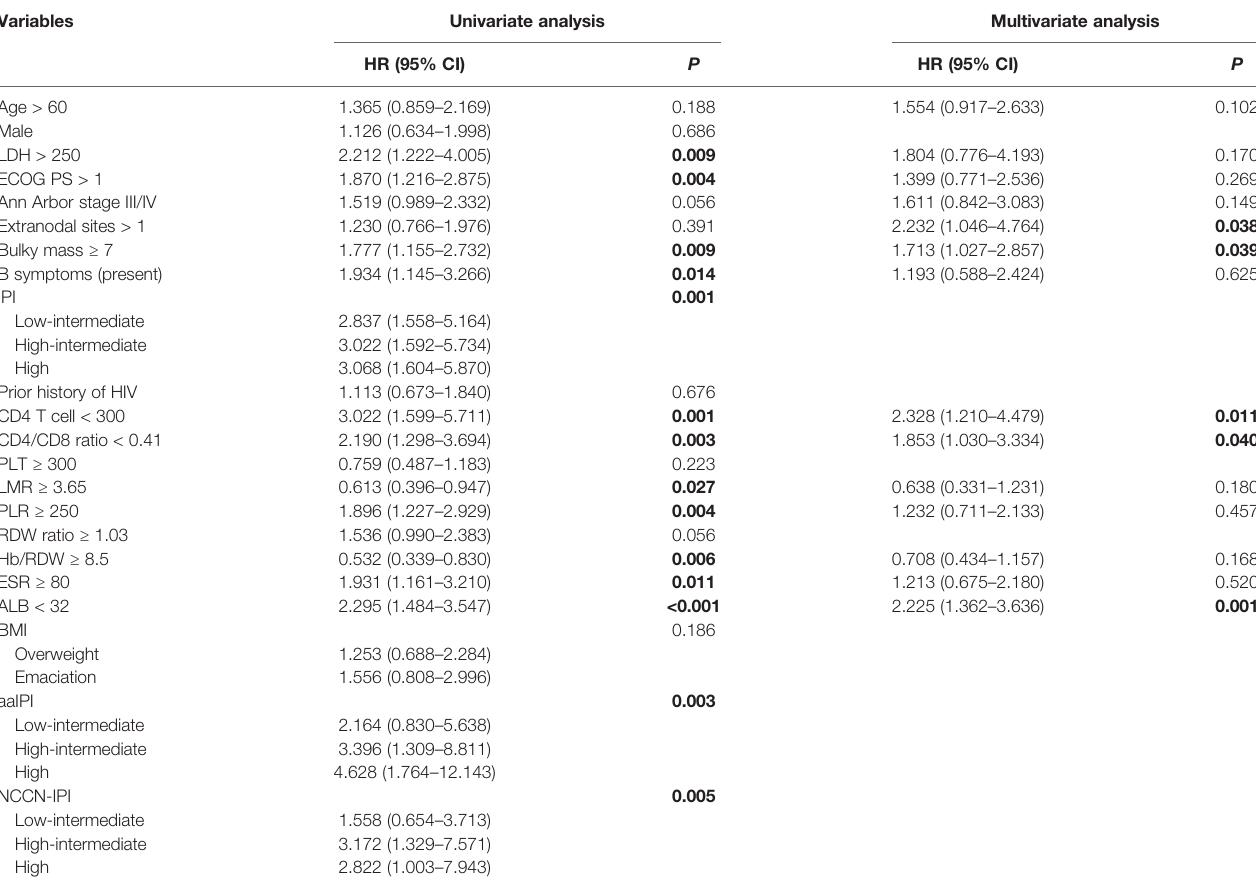
TABLE 3 | The factors associated with progression-free survival in patients with AIDS-related lymphoma ( n = 138).